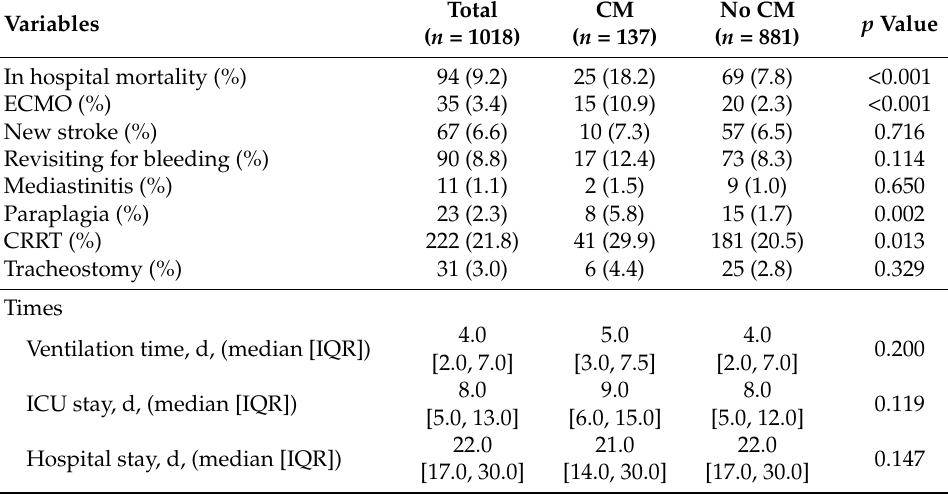
Table 3. Outcomes of the entire